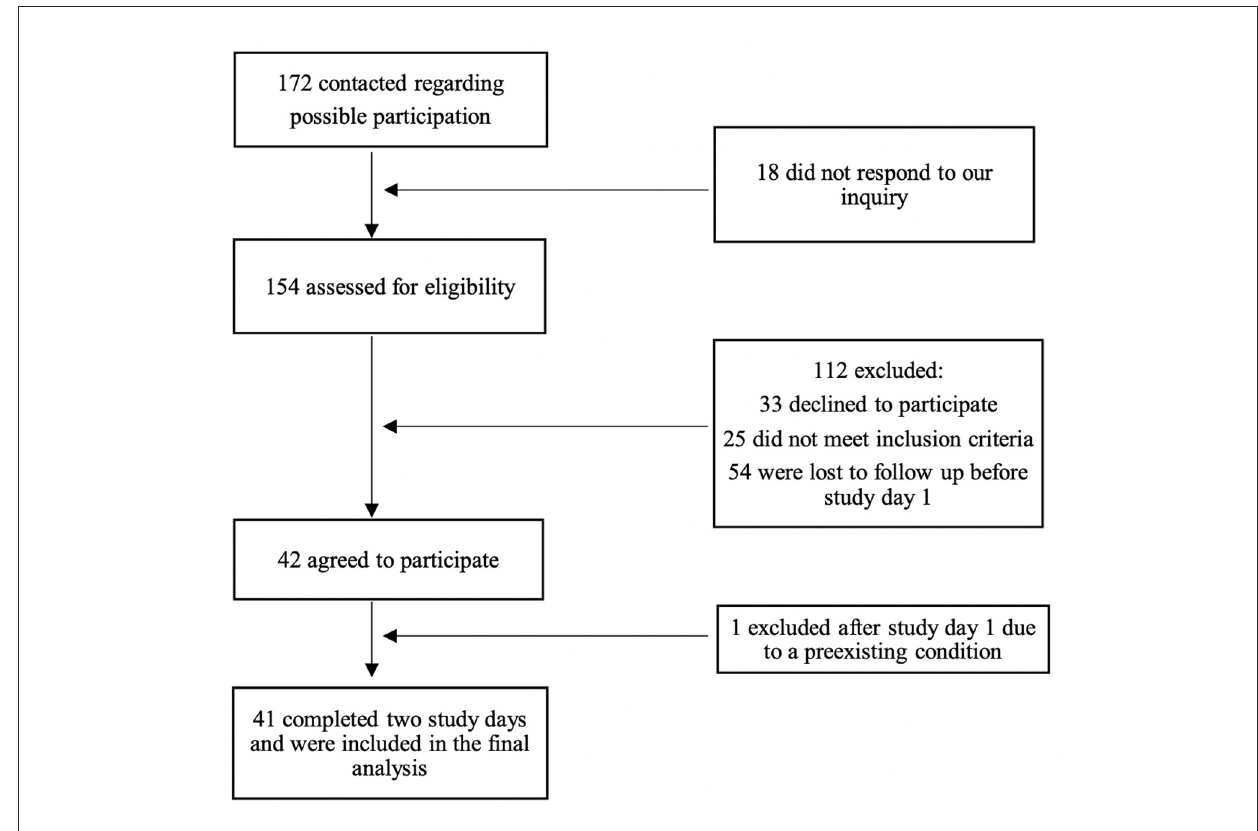
FIGURE1 Flowchart of the study.